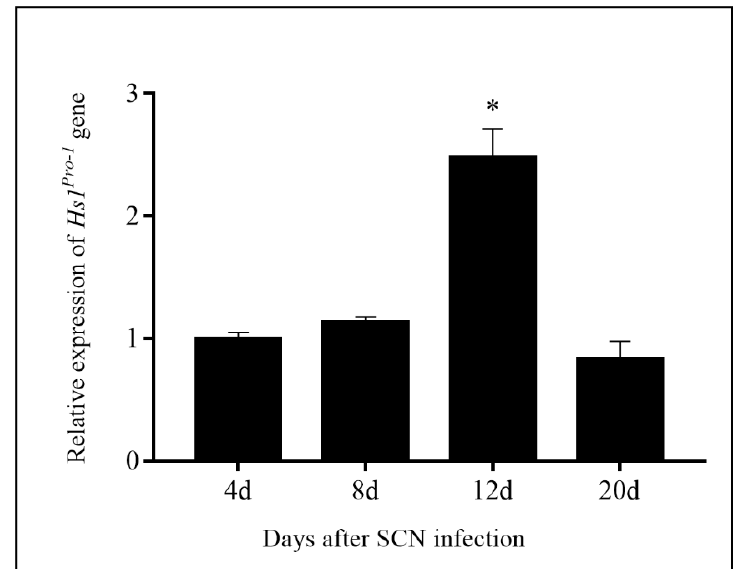
Figure 7. Relative expression of Hs1 pro − 1 gene in the roots of ZHs1-2 transformation events 4 d, 8 d, 12 d, and 20 d after SCN infection as determined by q RT-PCR. Expression was relative to that before SCN infection, the value of which was set as 1. The bars represent the standard error based on three independent biological replicates. Asterisks indicate significant differences at a level of 0.05 as determined by Duncan’s t -test.